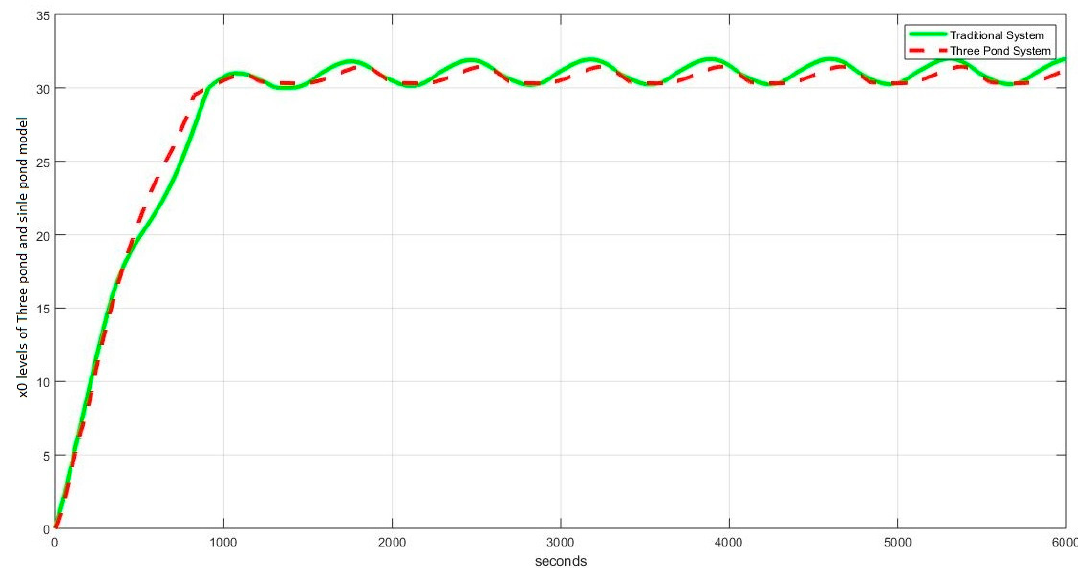
Figure 17. Comparison between the proposed system (half capacity) and the traditional system (sinusoidal disturbance).